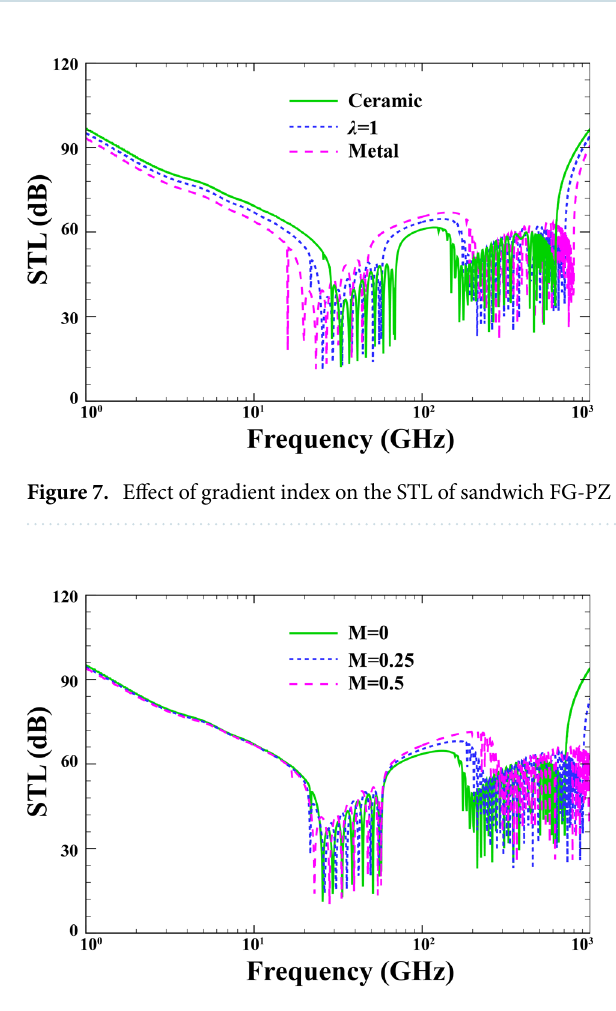
Figure 8. Effect of the external flow Mach number on the changes of STL.